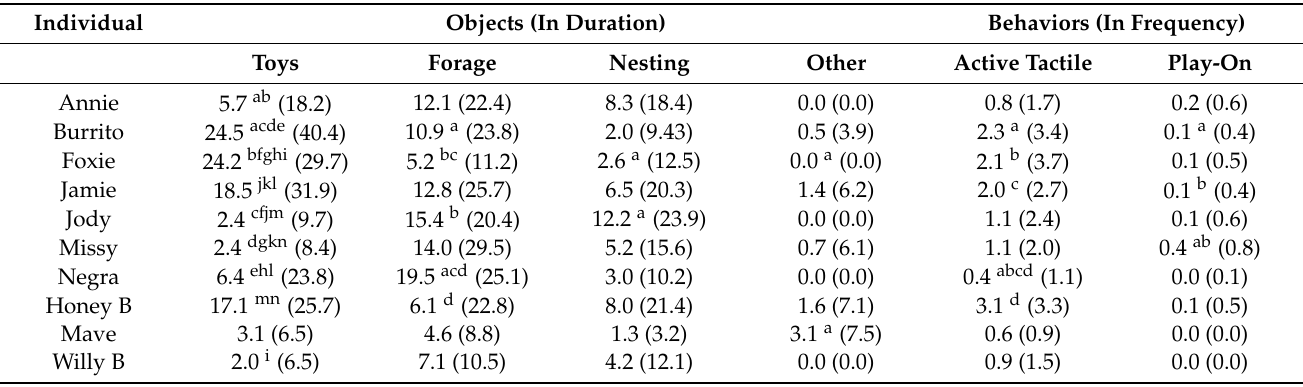
Table 8. Mean duration of enrichment object use and mean frequency of manipulation behaviors for each individual (SDs in parentheses; n =